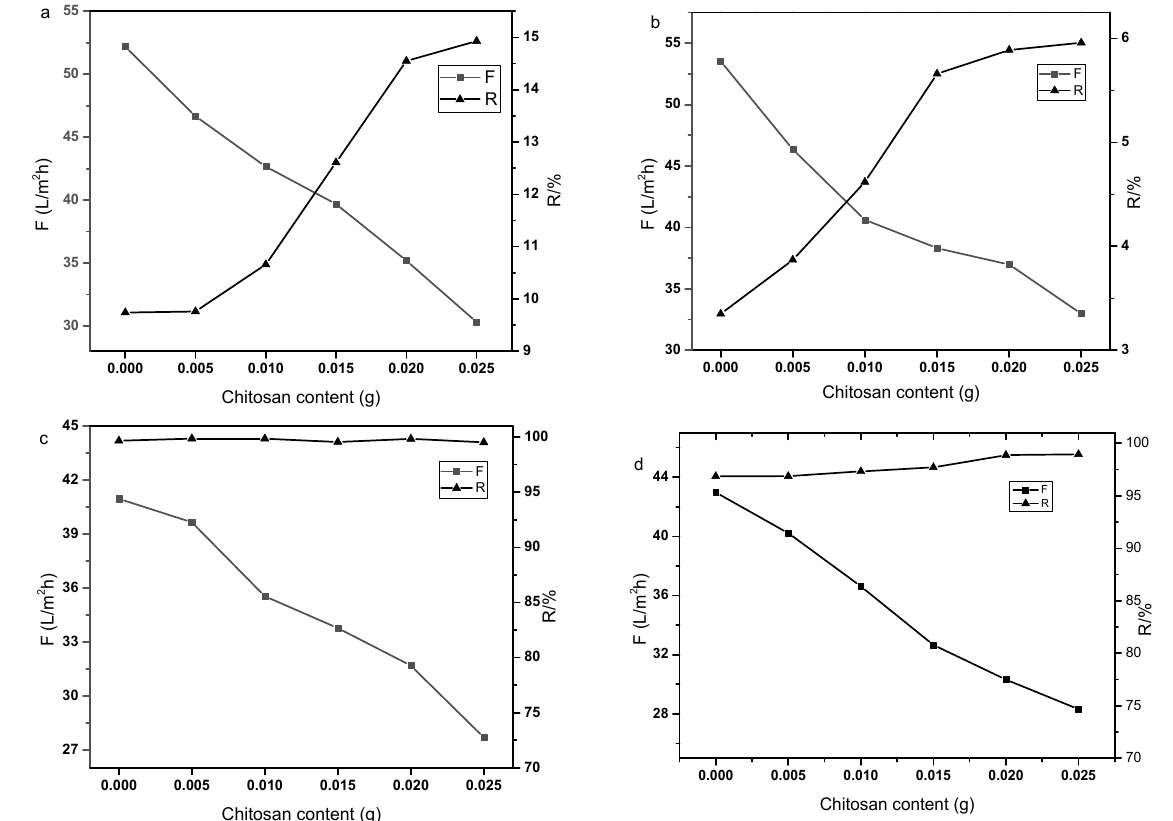
Figure 2. Effect of chitosan content on the membrane performance (( a ): Na 2 SO 4 , 1 g·L − 1 ; ( b ): MgCl 2 , 1 g·L − 1 ; ( c ): Congo red, 50 mg·L − 1 ; ( d ): Methyl orange, 50 mg·L − 1 ).